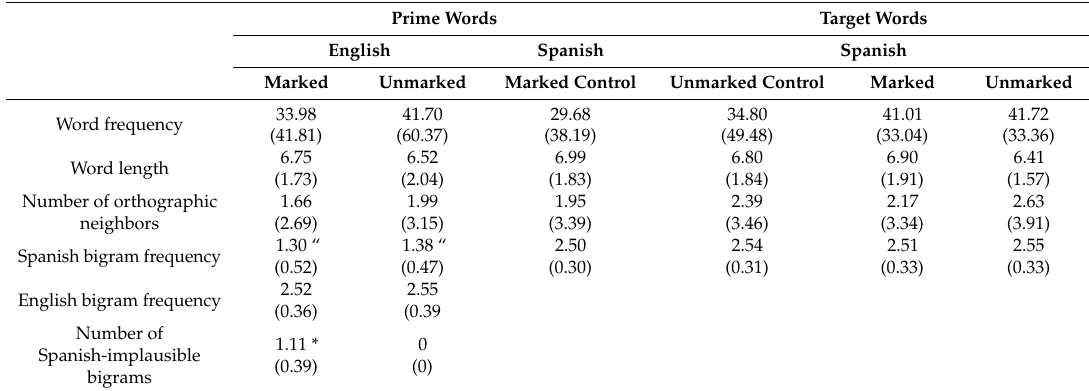
Table 4. Experiment 2: Mean values for each factor in Spanish and English prime words for each condition, marked and unmarked. Standard deviations are provided within